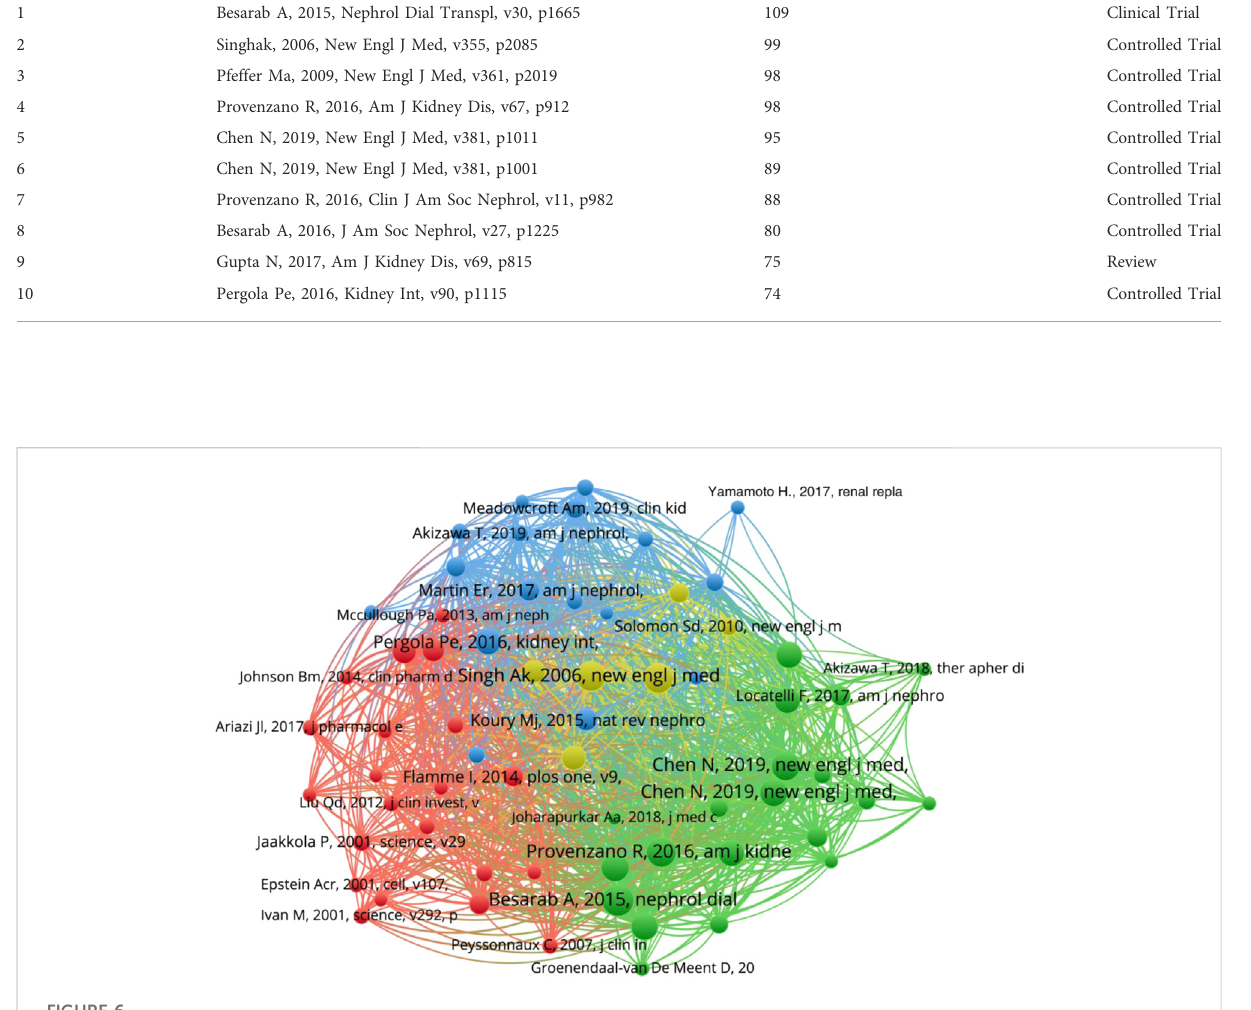
FIGURE 6 The co-word network visualization of co-cited references in